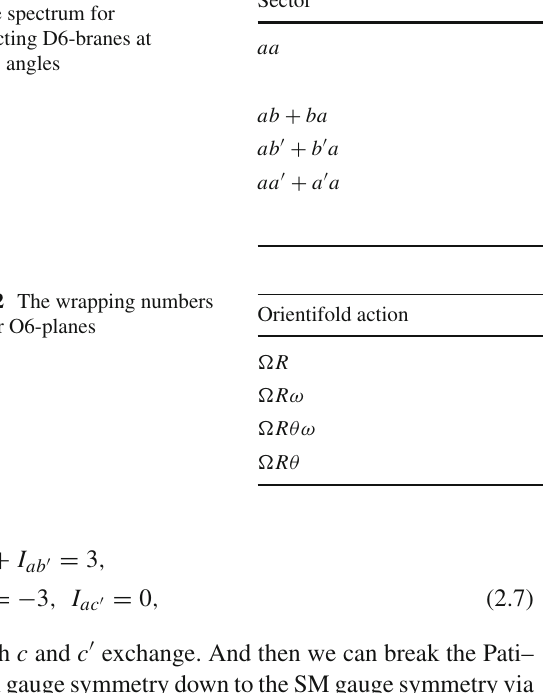
Table 1 General massless particle spectrum for intersecting D6-branes at generic angles